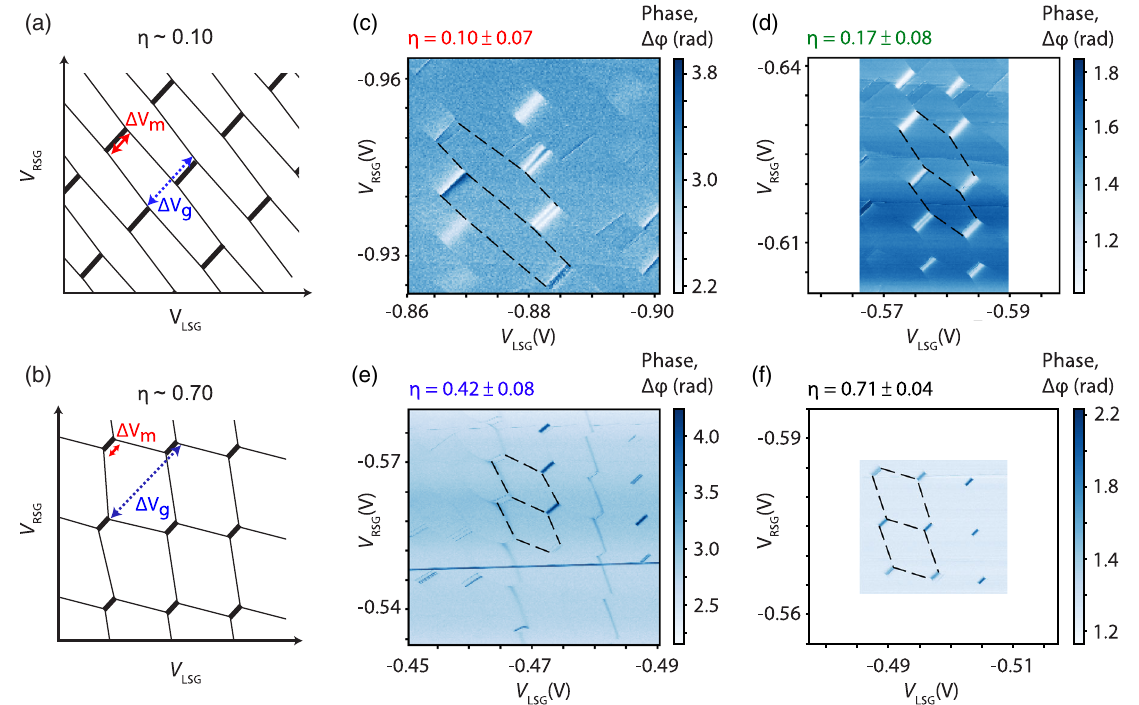
FIG. 2. DQD charge stability diagrams. (a) A schematic of a DQD charge stability diagram for a configuration with a large mutual capacitance C , resulting in η ∼ 0 . 10 . The black areas (lines) represent interdot (QD m strength η is determined directly from the charge stability diagrams. Δ V and QD-lead energy degeneracies, respectively. (b) The same as (a) but for smaller C charge stability diagrams obtained for four different DQD configurations in correspondence of four distinct values of C from (c) to (f)]. Each charge stability diagram is measured by monitoring the change in the phase Δ ϕ of the resonator reflectance in response to the DQD gate voltages. The axes scales of the LSG and RSG gate voltages are kept the same in the four panels for ease of